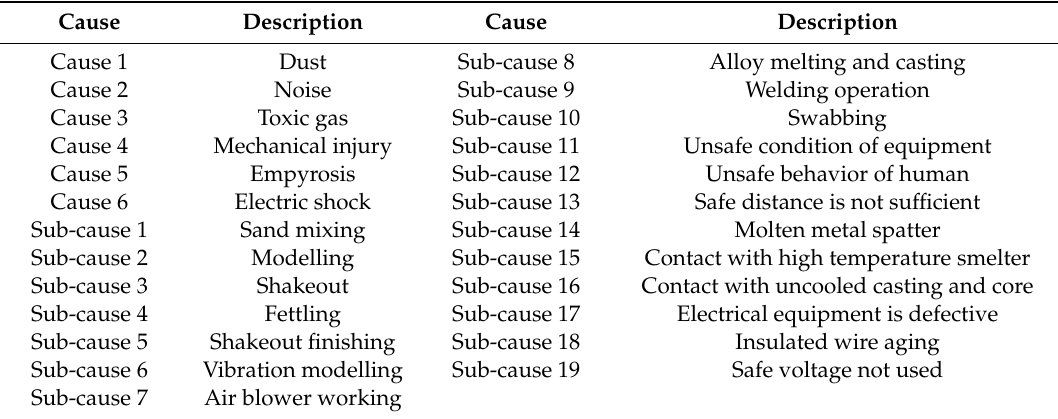
Table 5. Detailed description of causes.